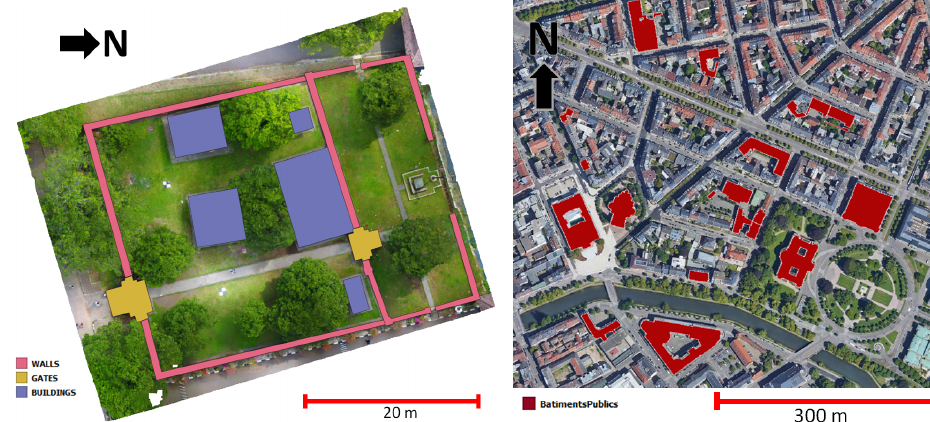
Figure 4. The GIS shapefile data used to help the segmentation process. On the left, three shapefiles were available for the Kasepuhan dataset while, on the right, only one shapefile entity was used for the St-Pierre dataset.